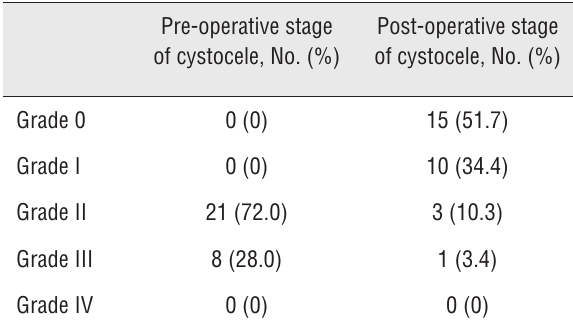
Table 3 – Anatomical outcomes.